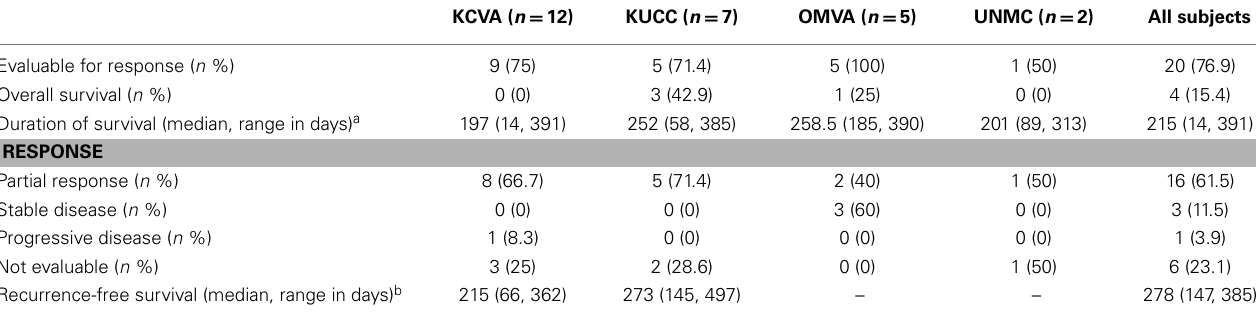
Table 3 | Response evaluation .